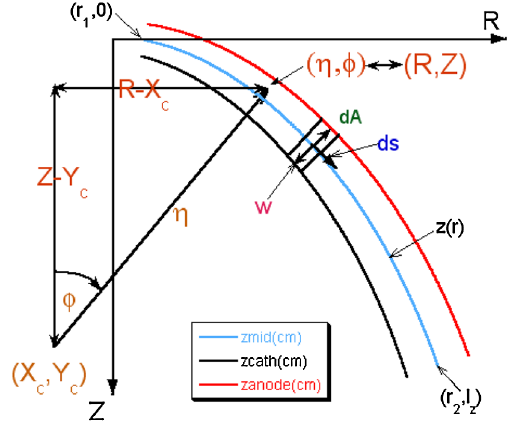
FIG. 1. (Color) Midgap and electrode curves in ð r; z Þ and ð (cid:5); (cid:6) Þ coordinate systems, geometry and coordinate systems corre- sponding to an axisymmetric TL. The midgap and electrode curves in R , Z are schematically depicted (cathode in black, anode in red, midgap in blue). The actual TL surface is a figure of revolution around the axis of symmetry. The TL gap w and the differential of arclength ds along the midgap curve are shown, as ; 0 Þ , ð r ; l well as its end points ð r z Þ . The polar coordinate system 1 2 ; Y (cid:5) in the (cid:5) , (cid:6) with variable center of curvature at ð X c c Þ and direction of the local radius of curvature is exhibited. Also indicated is the differential area dA used in the approximation explained in Eq. (2). For definition of terms see